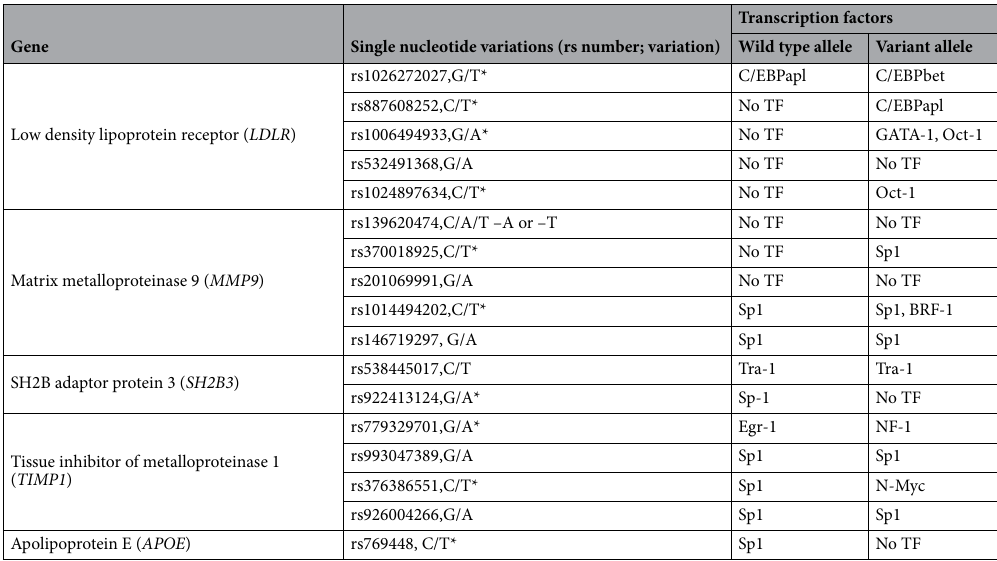
Table 2. Transcription factors associated with the single nucleotide variations (SNVs) abolishing CGIs. *change in transcription factor binding; No TF: No transcription factor